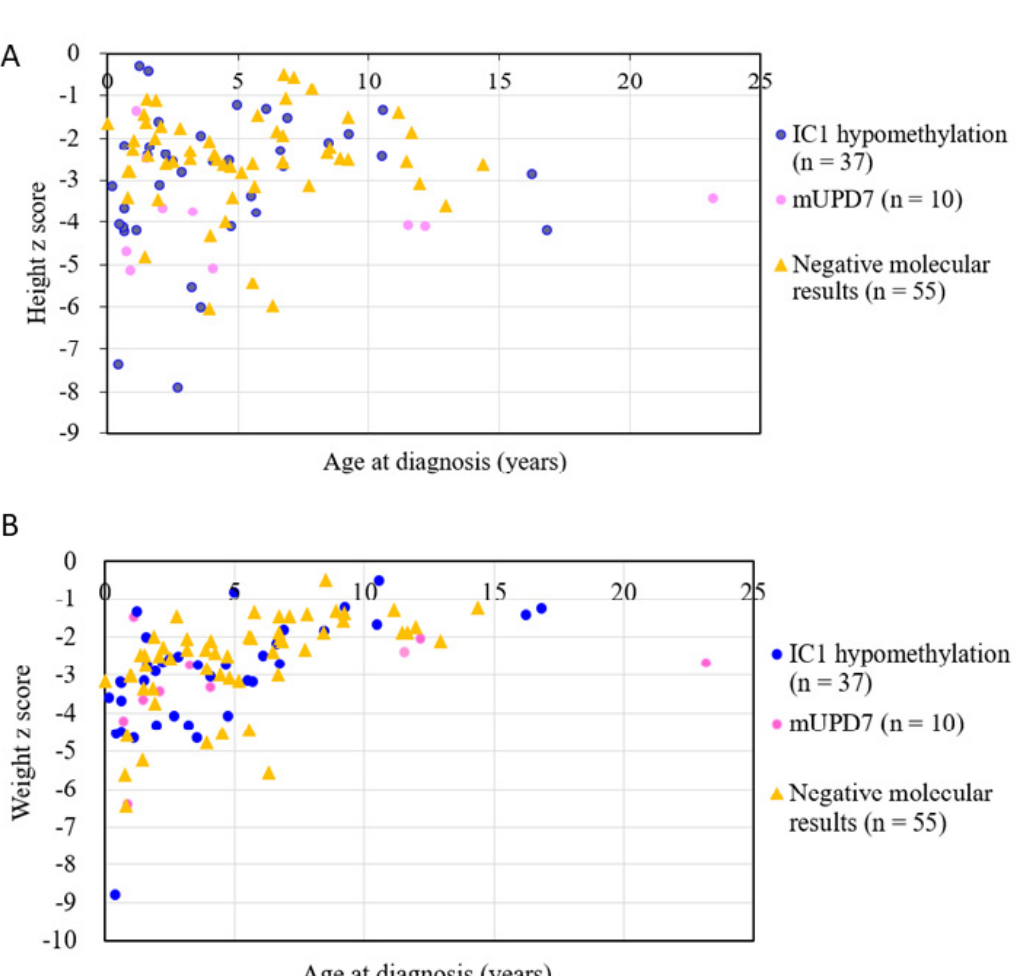
Figure 3. The relationships between the age at diagnosis and ( A ) height z score ( n = 102, r = 0.069, p > 0.05) and ( B ) weight z score ( n = 102, r = 0.509, p < 0.001) among 47 subjects with identified molecular defects (37 subjects with IC1 hypomethylation and 10 subjects with mUPD7) and 55 subjects with an SRS score ≥ 8 and negative molecular results. SRS: Silver–Russell syndrome; IC, imprinting center; mUPD7: maternal uniparental disomy of chromosome 7.